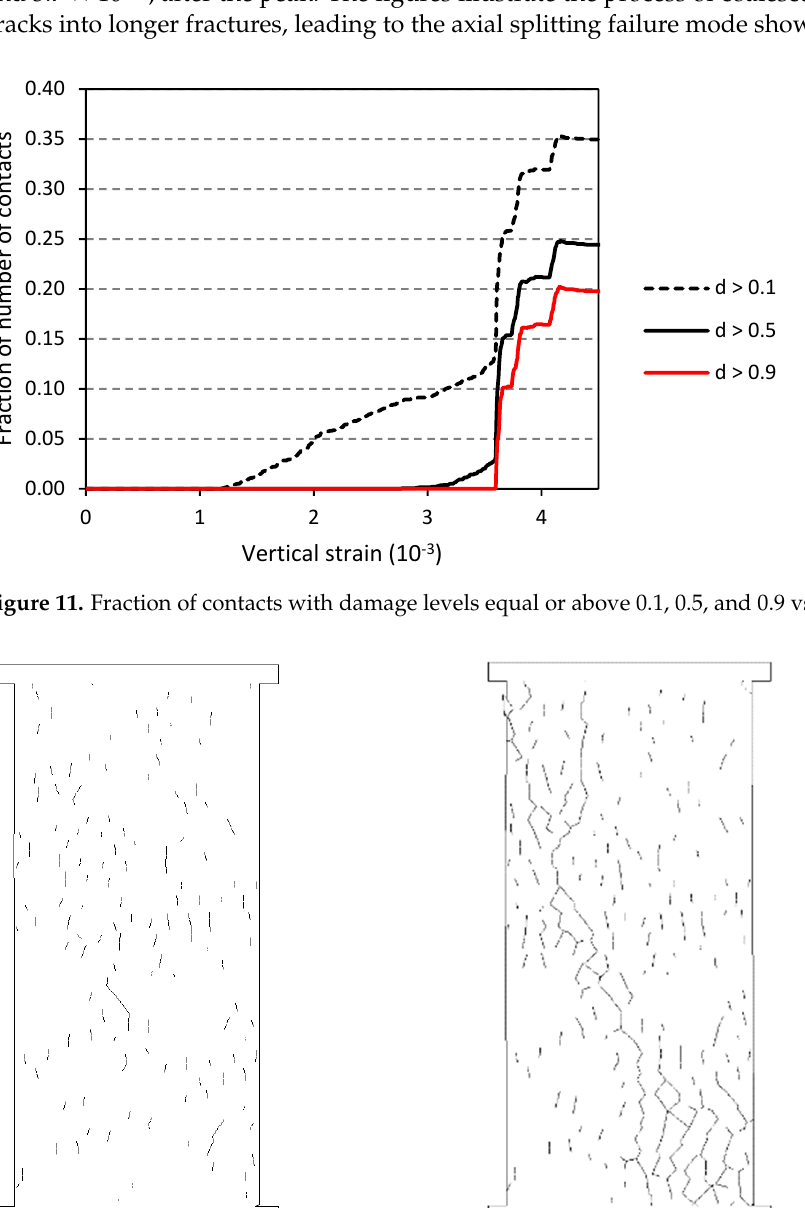
15 of 26 Figure 10. Failure model under vertical compression. An insight into the progression of the failure process can be gained by monitoring the increase in the damage in the contacts. If we define a damage indicator as the percentage of the loss of strength, starting at 0 at peak and reaching 1 at the residual state,